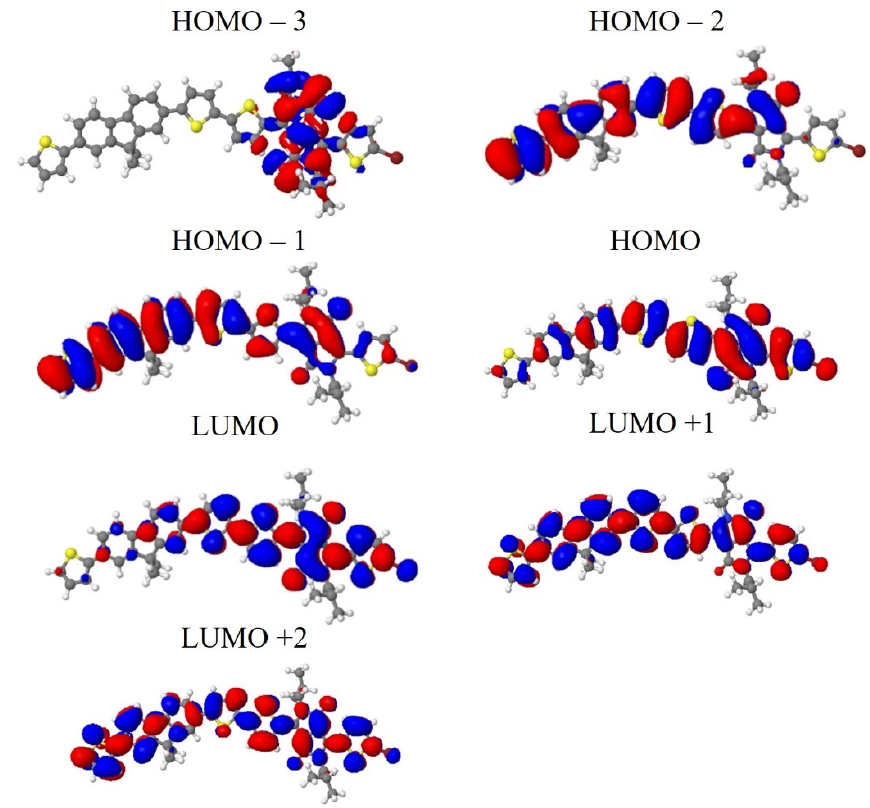
Figure 16. Frontier molecular orbital transitions responsible for the major bands observed in the UV–vis absorption spectra for the PFDPP polymer. Table 5. Absorption transitions for each absorption band. From To Energy Gap (eV) λ (nm) The absorption band at 350 nm Oscillator Strength = 0.70